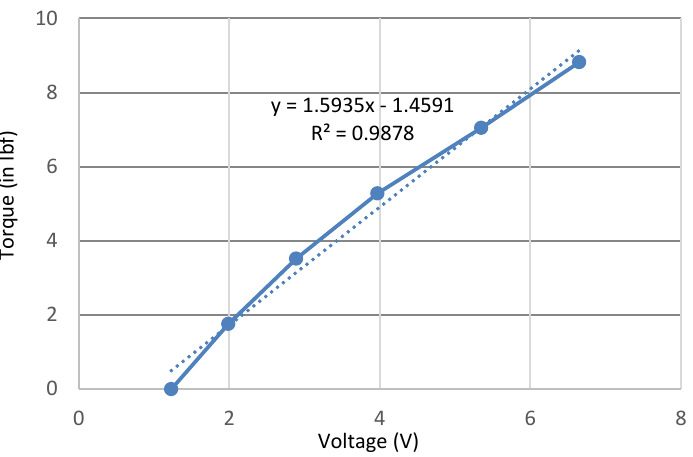
Figure 9. Torque sensor calibration.